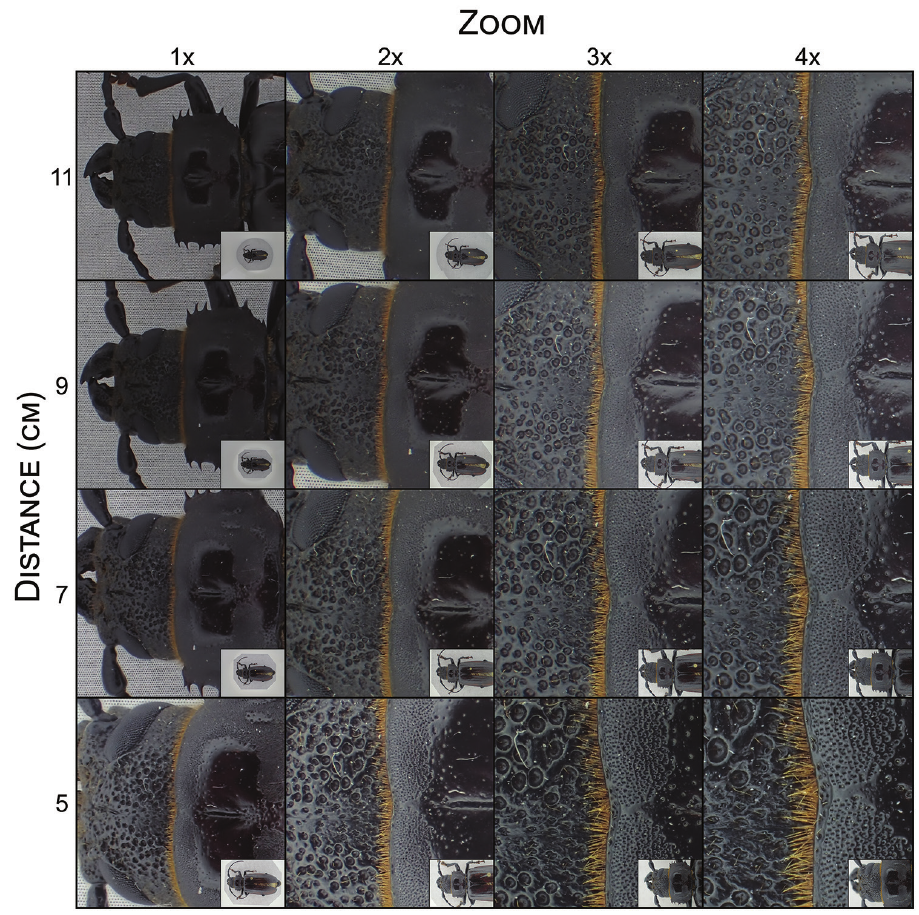
Figure 2. Visualization of the variation in image quality, level of detail and proportion of the specimen fitting the frame (insets) at different levels of optical magnification (1–4 times) and distance from the lens (11–5 cm). Every image, shot with the compact camera, is composed of 29 manually stacked images at the narrow setting and cropped to equal dimensions (approx. 1/24 of the original image). Quality and detail improve as lens distance decreases and/or the zoom increases at the cost of reduced depth of field and a smaller portion of the specimen fitting the image